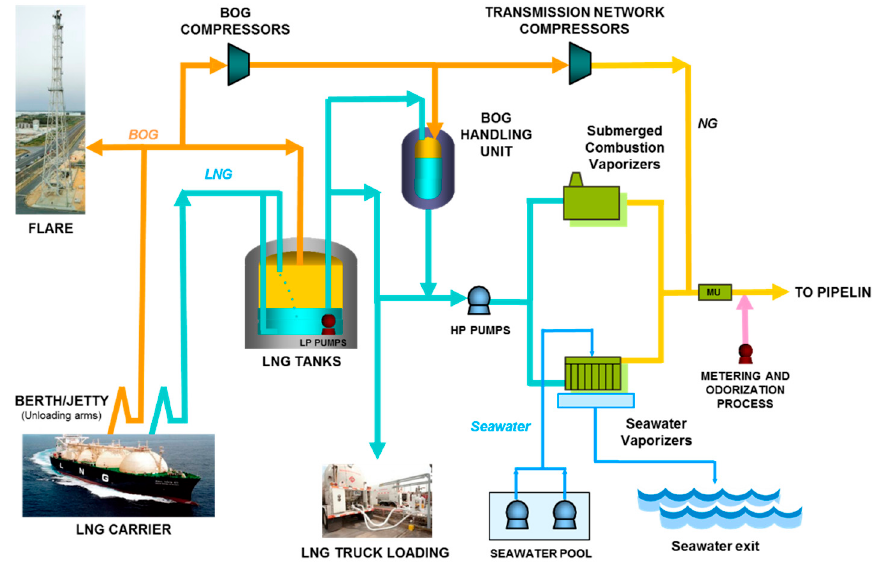
Figure 1. LNG regasification—conventional process.